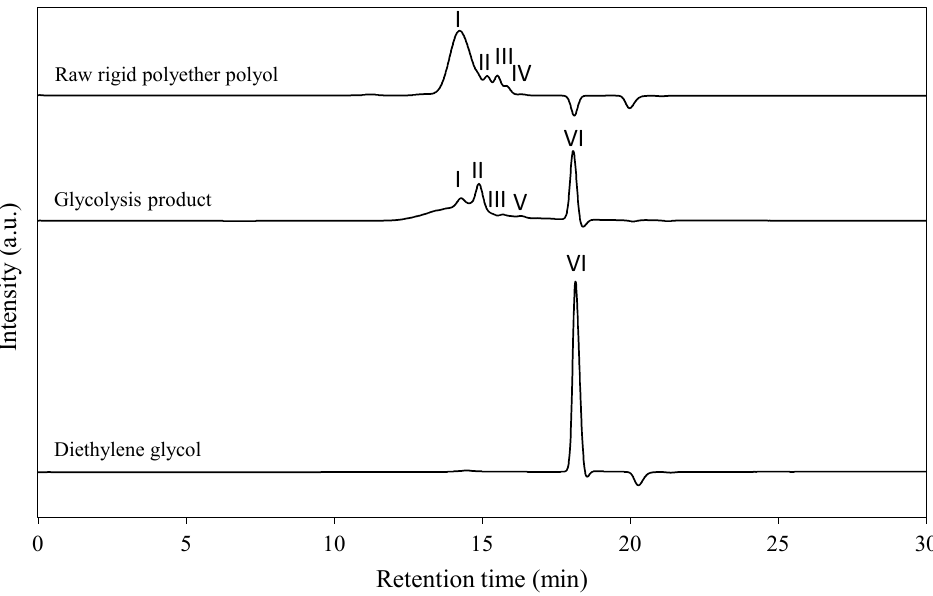
Figure 2. GPC chromatograms of the glycolysis product at 360 min in comparison with GPC chromatograms of raw rigid polyether polyol and DEG. Peaks I, II, III and IV = rigid polyether polyol; Peak V = reaction byproducts; Peak VI = DEG.